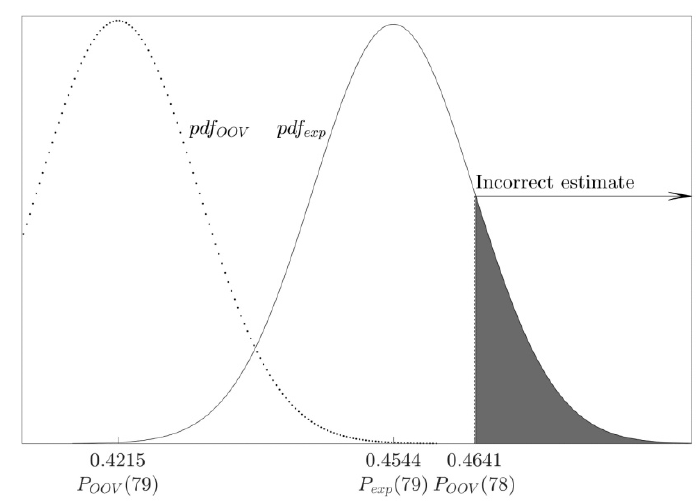
Figure 9. The probability of an incorrect 0-bit guess when the weight estimate is correct: After flipping a 0-bit, acceptance rate c (cid:3030) of the noise vector ( = 78), the OOV algorithm estimates a bit as 0 i ff c